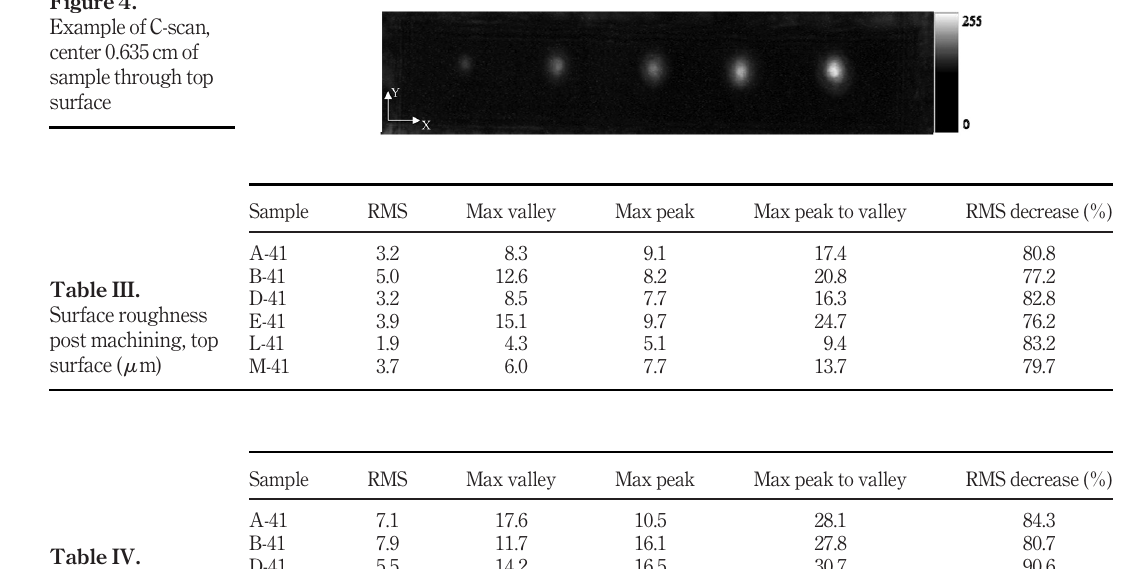
Table IV. Surface roughness post machining, side surface ( m m)